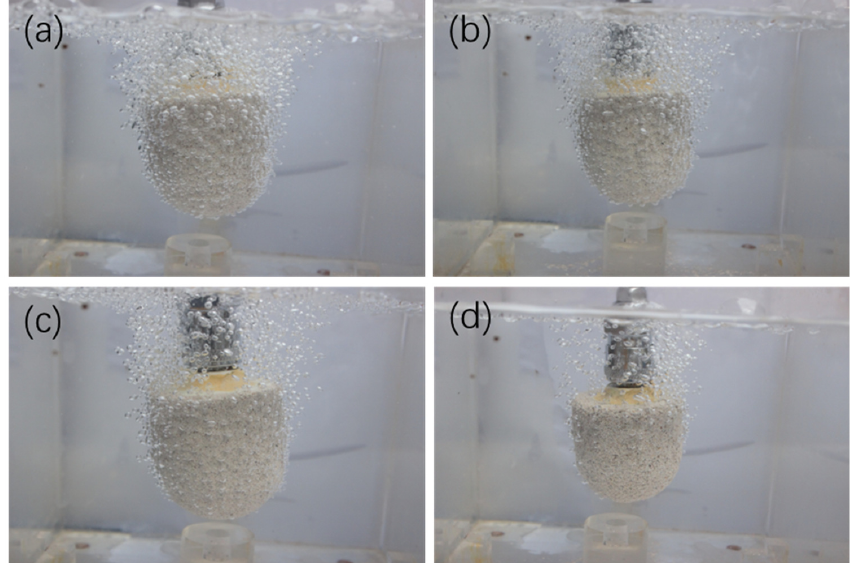
Figure 6. The hydraulic simulation photo of the porous nozzle with different sizes of fine sand: ( a ) 50 mesh, ( b ) 100 mesh, ( c ) 200 mesh, ( d ) 300 mesh.